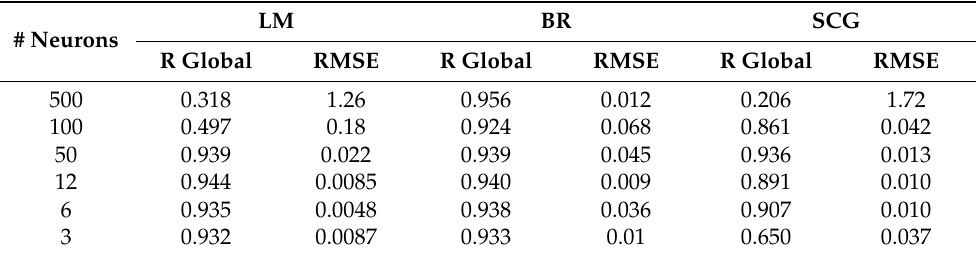
Table 8. Pearson’s correlation coefficient (R) and root mean square error (RMSE) values for trial and error using Levenberg–Marquardt (LM), Bayesian regularization (BR) and scaled conjugate gradient backpropagation (SCG)